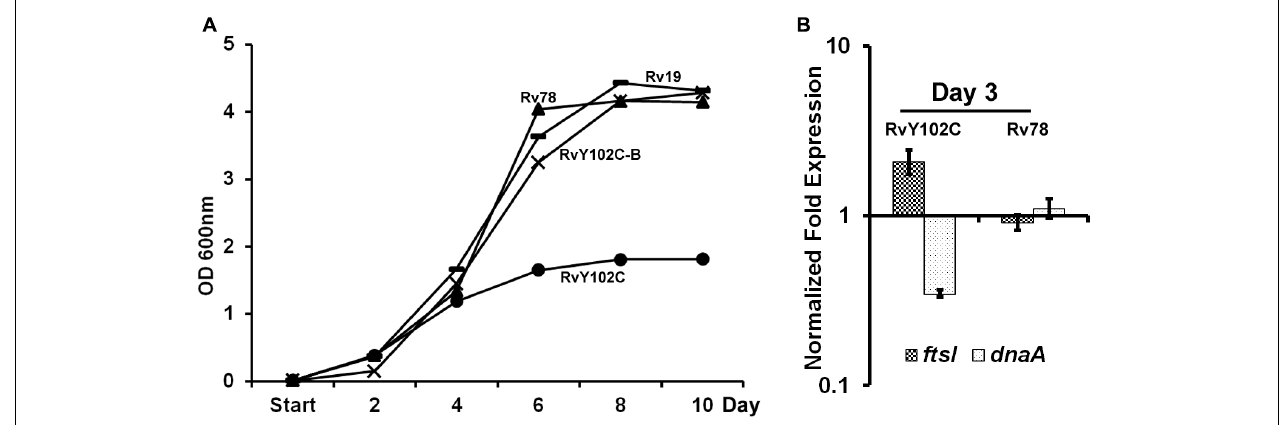
FIGURE 1 | Characterization of RvY102C. (A) Growth of M. tuberculosis Rv19, Rv78, RvY102C, RvY102C-B carrying empty vector, mtrA , mtrA Y102C and mtrA Y102C - mtrB plasmids, respectively (see Supplementary Table S2 ). (B) Expression of dna A and fts I in RvY102C (normalized to 16S rRNA) determined by qRT-PCR. Data shown are fold expression in Rv78 and RvY102C relative to Rv19. The total RNA was isolated from three independent biological replicates and the data are represented as the means ± standard errors from three independent experiments.